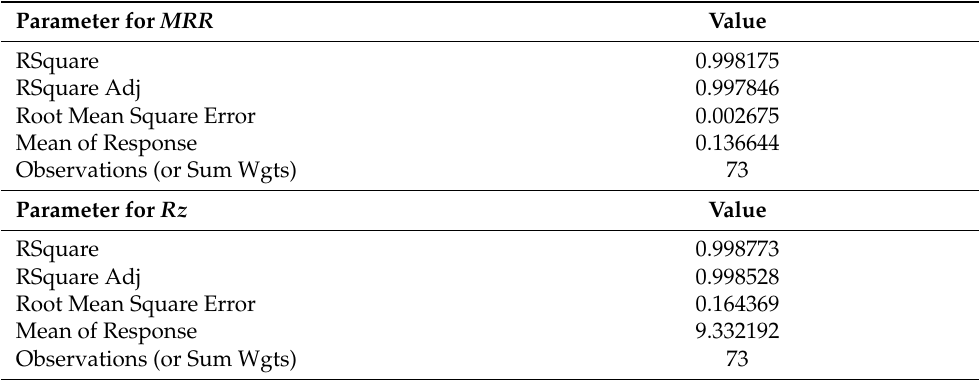
Table 6. Cumulative analysis of the quality of the fit of the MSC models for prediction of the output parameters MRR and Rz of the electrical discharge